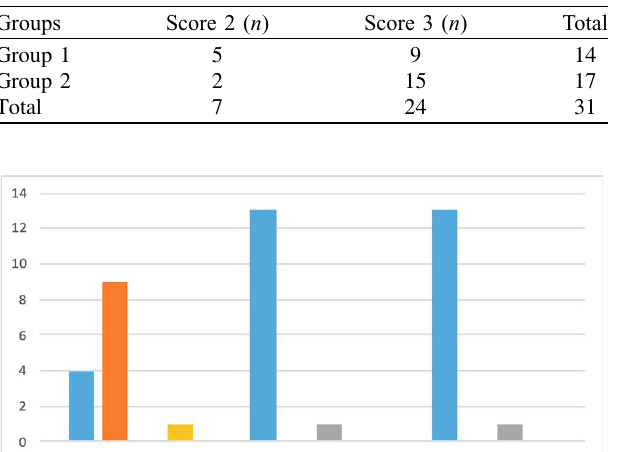
Table 2. Day 0 scoring of lice infestation in the cats from the two groups.